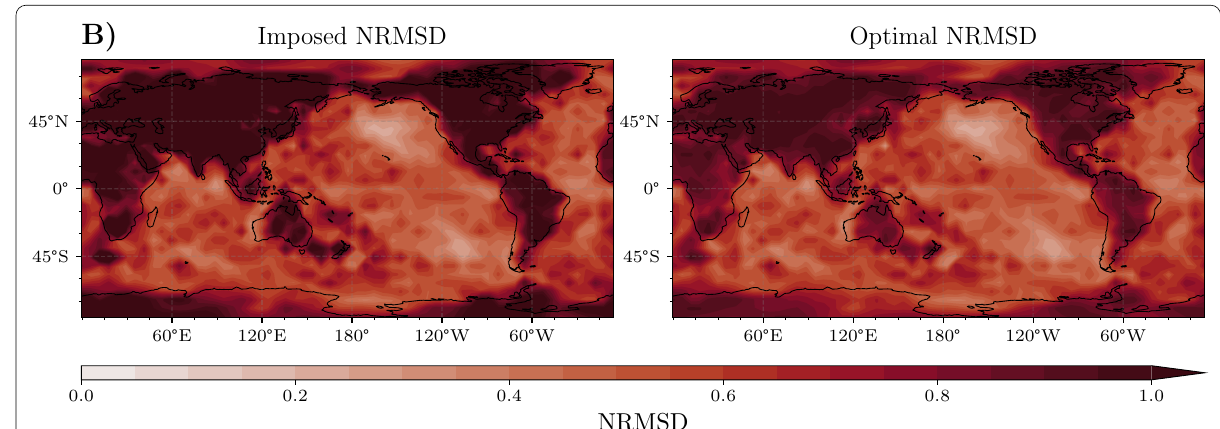
Fig. 11 The original deviations between the true and imposed OIMF anomalies (imposed NRMSD) are shown on the left. The deviations between true and theoretically best possible rescaled OIMF anomalies (optimal NRMSD) are illustrated on the right side. Both are shown exemplarily for the test case using a different true OIMF with a spatial oversampling up to SH 45. Dark colors indicate large discrepancies between the true and imposed (respectively, optimal rescaled) OIMF anomalies, and lighter colors accordingly, a good agreement. Both plots do not rely on assimilation